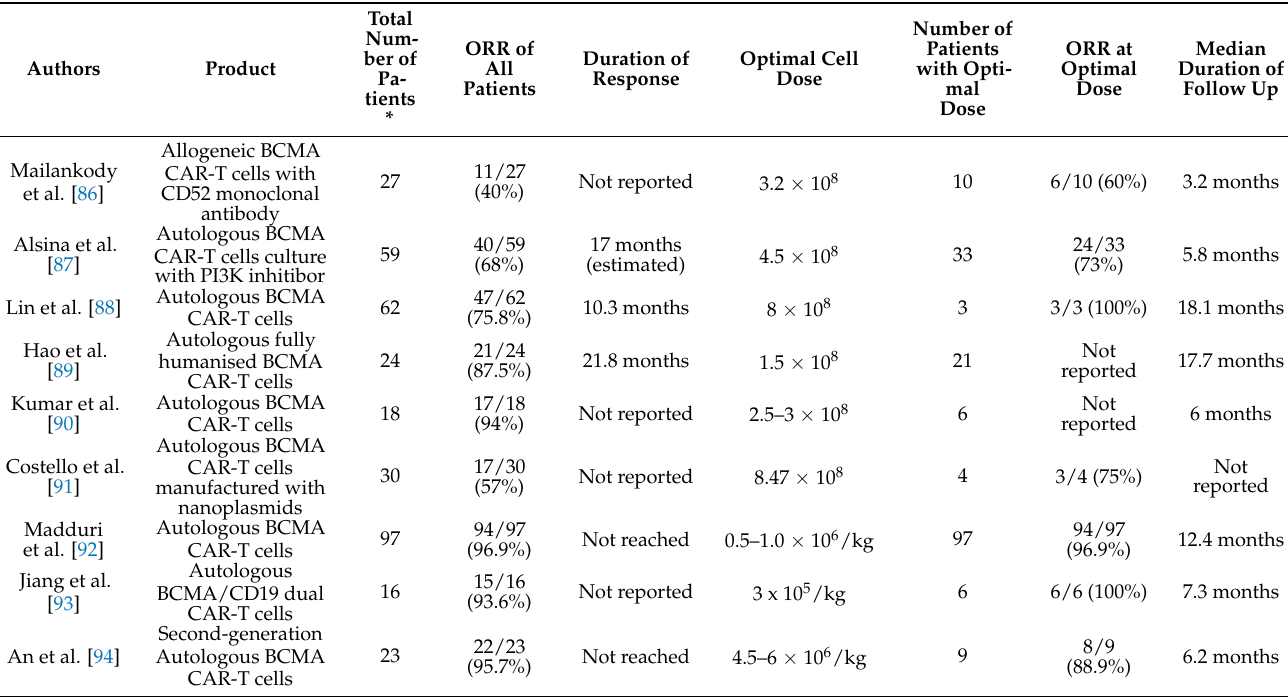
Table 1. CAR-T cell studies presented as oral presentations at the American Society of Haematology Scientific